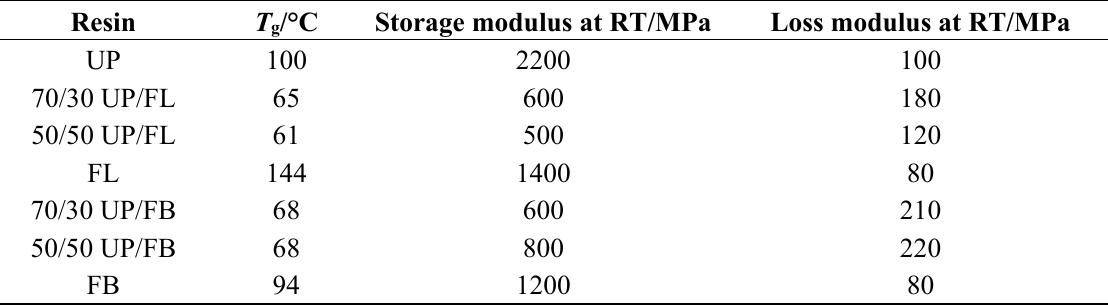
Figure 3. Tan δ vs . T for ( a ) cured UP, FL and UP/FL blends and ( b ) for cured UP, FB and UP/FB blends. Table 1. T g and moduli for cured resins and resin